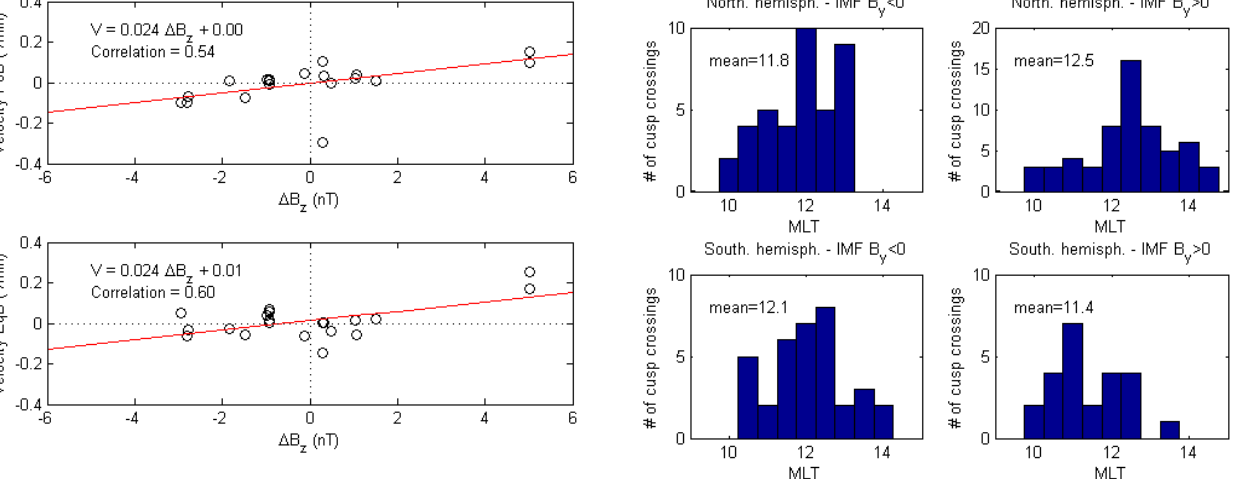
Fig. 12. Variations of the velocity of the poleward (top) and equator- ward (bottom) boundaries of the cusp as a function of the variation in B z . Only pairs of spacecraft crossing the same cusp not more than 30min apart and under steady or rotating IMF are considered.